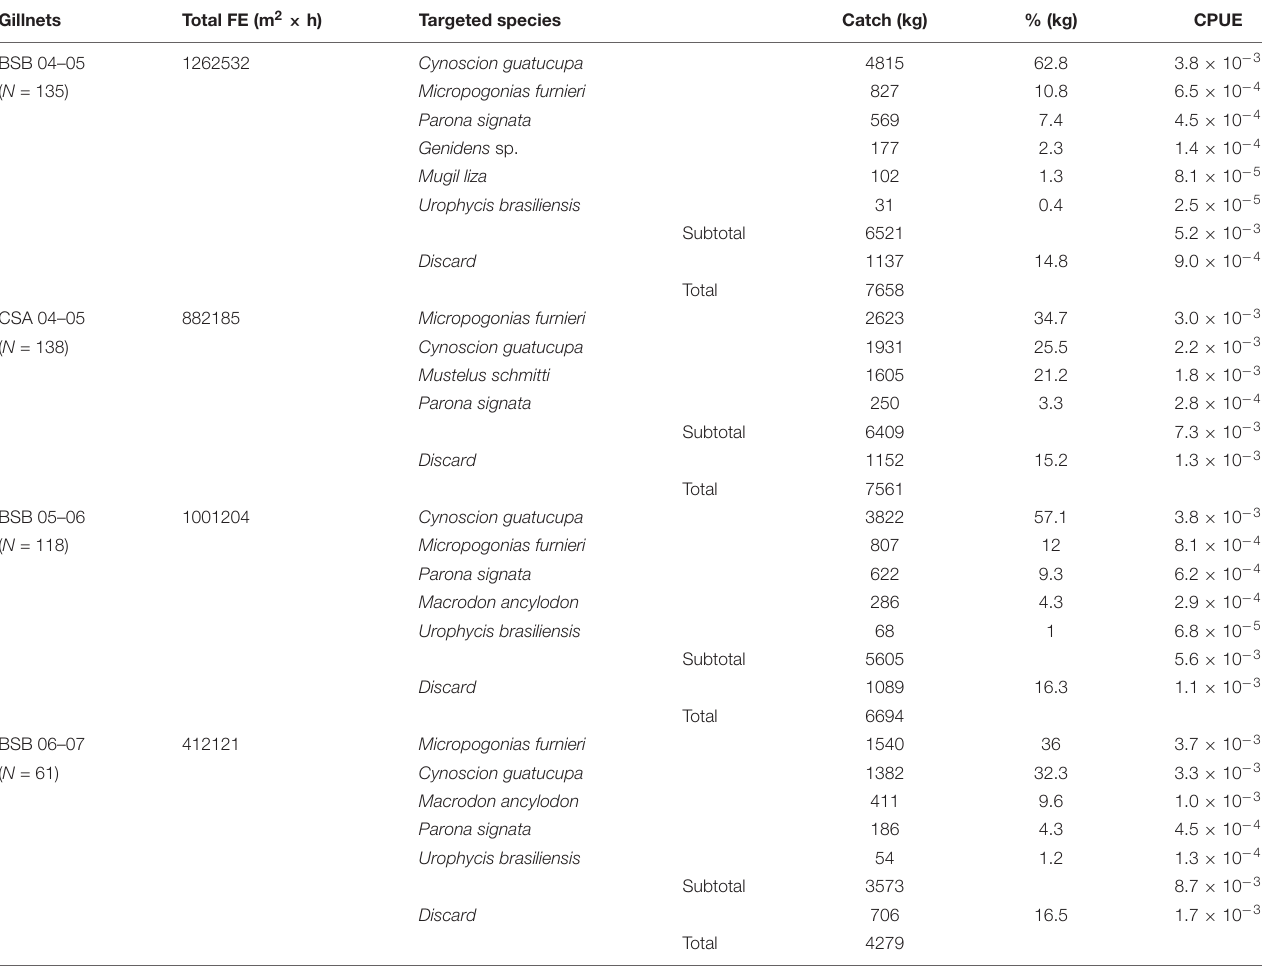
TABLE 1 | Summary of commercial fish catch and discard in gillnet hauls.